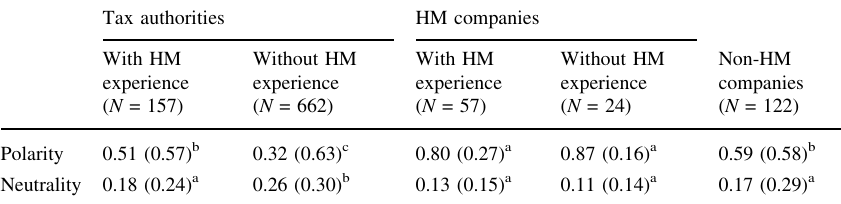
Table 4 Neutrality and polarity indices by stakeholder groups (means and SDs) Tax